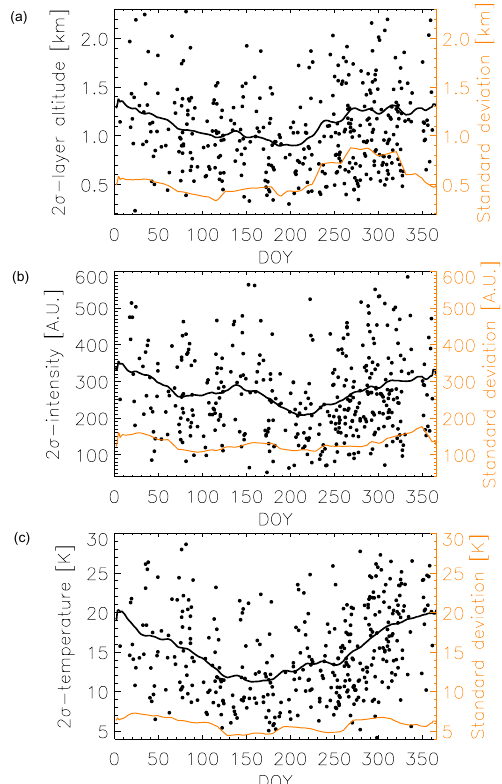
Figure 7. SATI 2002–2015 OH predicted altitude (a) , total band intensity (b) and rotational temperature (c) peak-to-peak nocturnal variability (2- σ ) versus day of the year: daily values (black dots), and 60-day running means (black line) and their standard deviation